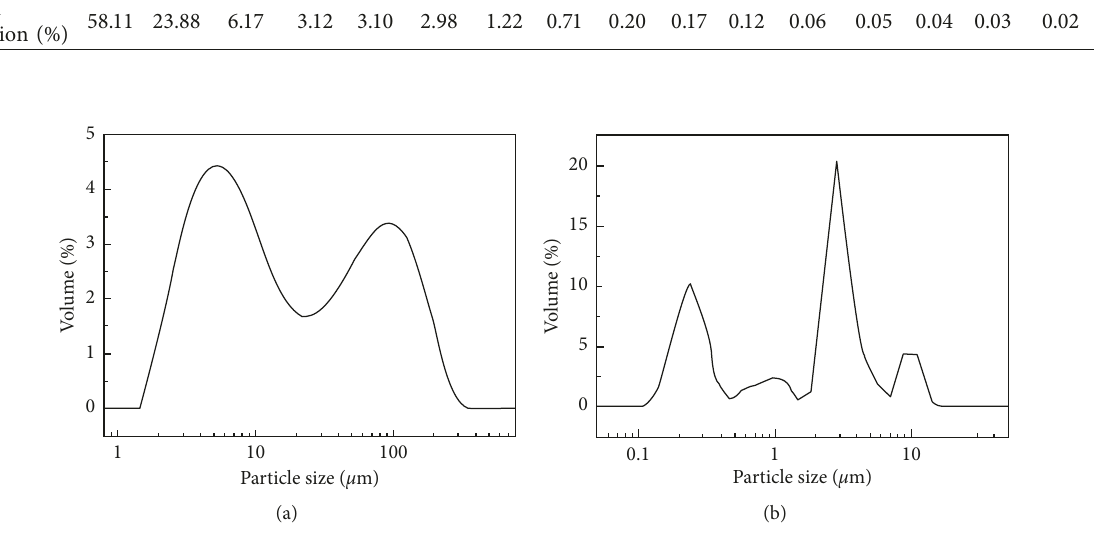
Figure 1: The grain size distributions of (a) plaster and (b) OPC.